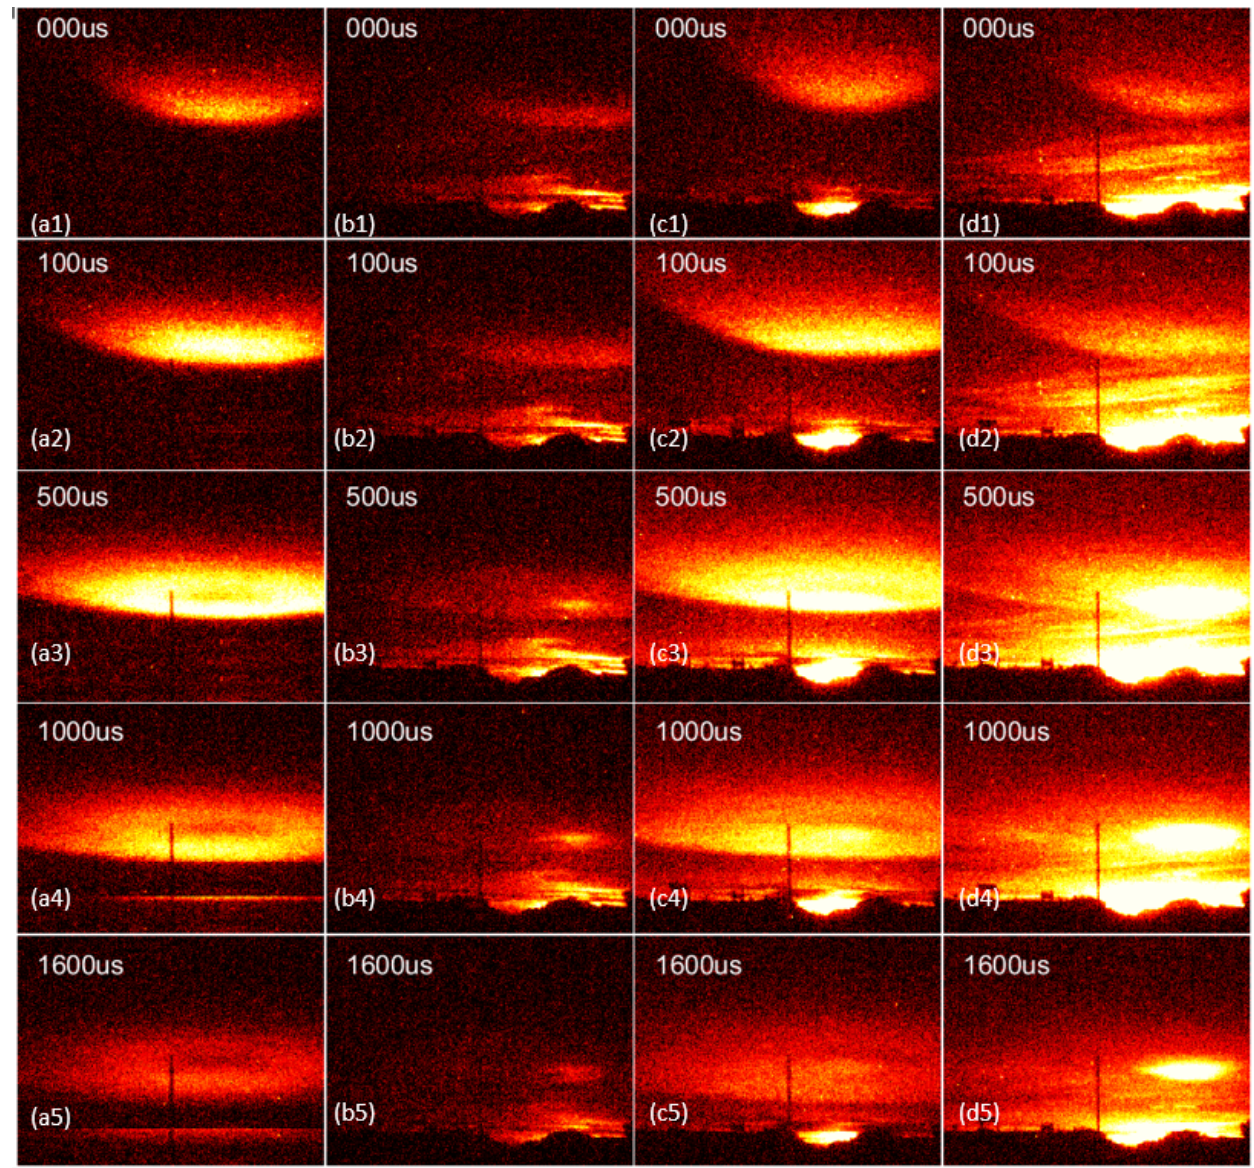
Figure 9. The recorded images by the high-speed camera system (10,000 fps) at GPS time ( a1 – a5 ) 13:07:25.9316 for elve, ( b1 – b5 ) 13:56:28.3870 for sprite halo, seeing detailed in Figure 11, ( c1 – c5 ) 15:00:13.2524 for elve and ( d1 – d5 ) 16:24:03.5149 (UT) for halo on 22 June 2020 where the corresponding time-tags are shown in units of μ s.